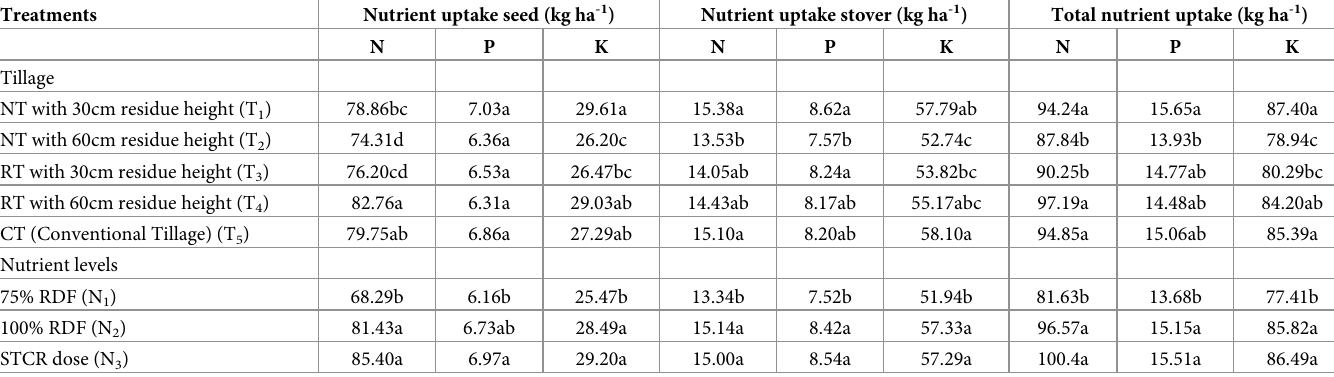
Table 4. Effect of tillage practices, crop residue management and nutrient levels on nutrient uptake of chickpea.